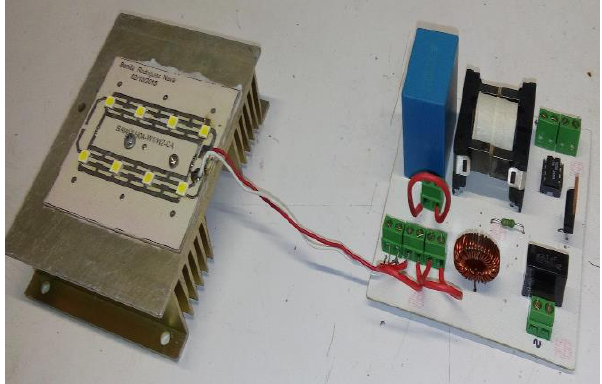
Figure 14. Prototype of the topology for experimental tests.